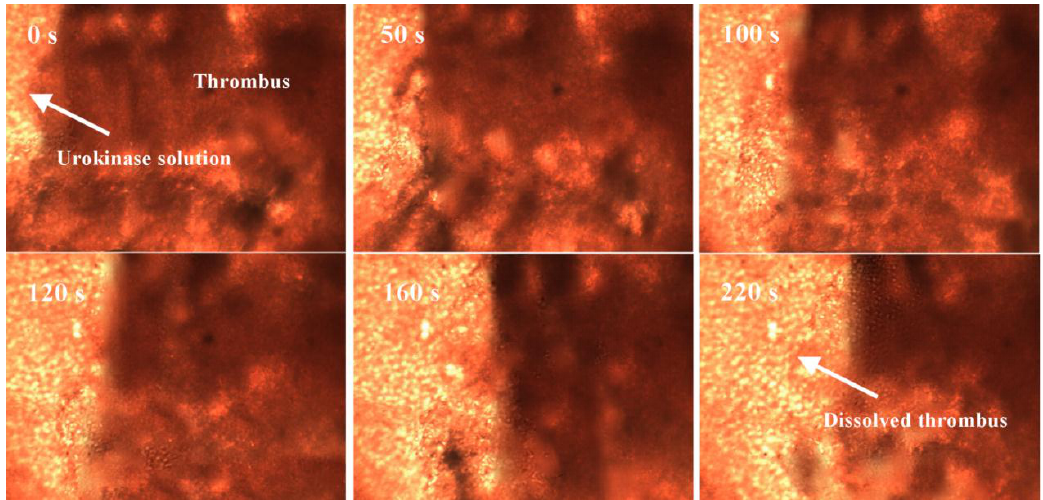
Figure 5. Image sequences demonstrating a pure urokinase-mediated thrombus removal process.